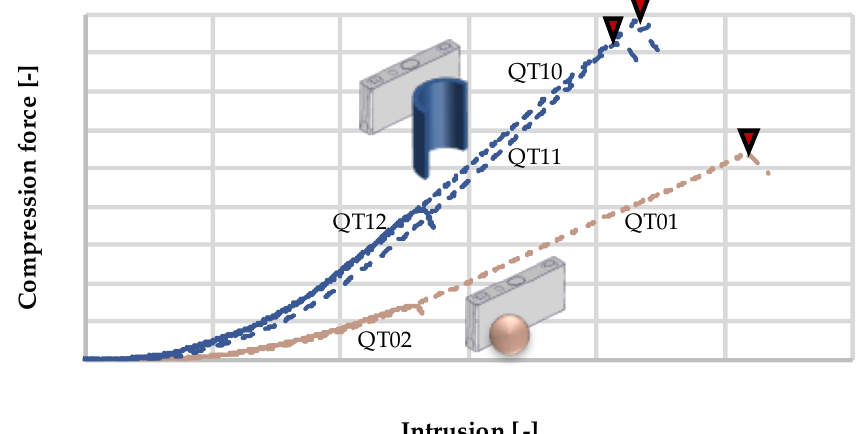
Figure 2. Compression force over intrusion in u-direction.